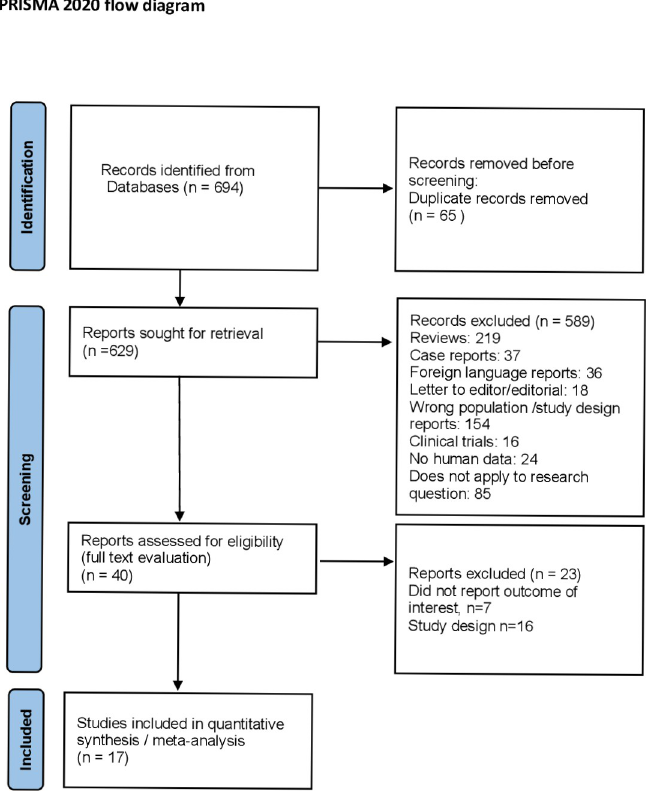
Fig 1. PRISMA flow diagram of the selection process from identified studies to selected studies through Medline and Cochrane Library.